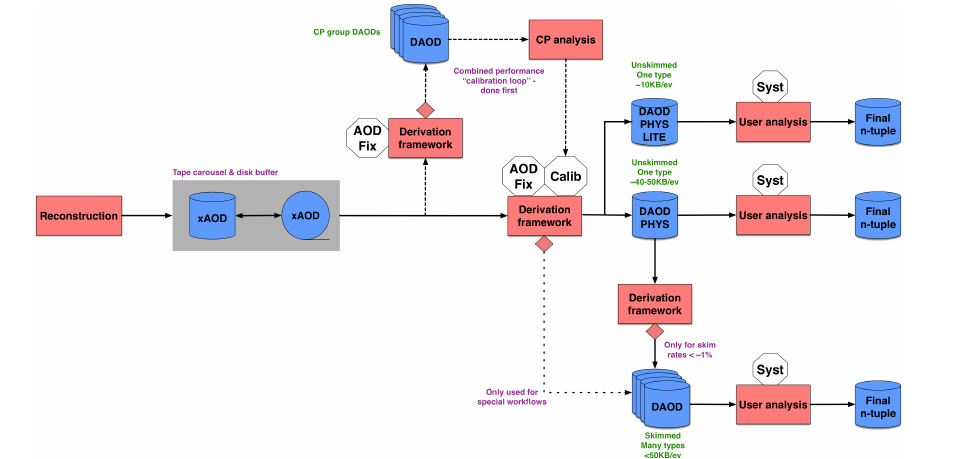
Figure 4: The new production workflows and formats recommended by the AMSG-R3.